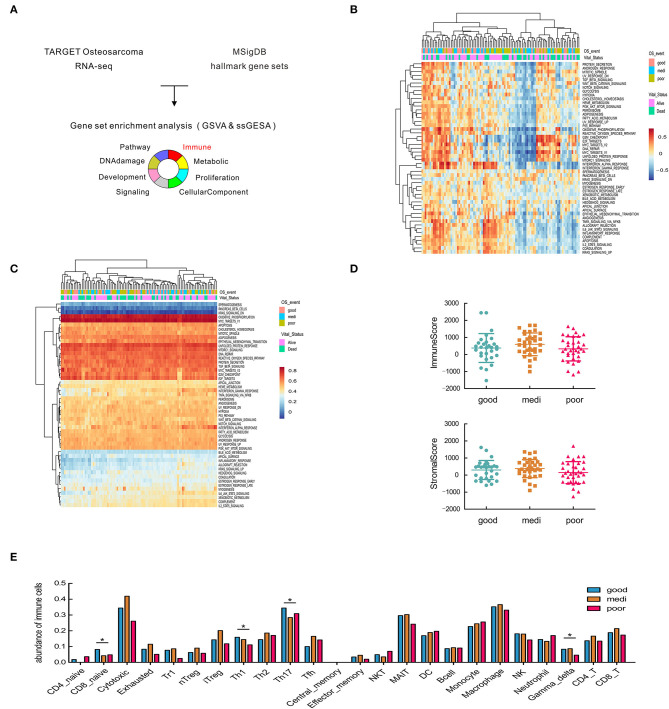
Significant heterogeneity in immune-related gene sets among patients with osteosarcoma and its correlation with disease prognosis. (A) Schematic representation of gene set enrichment analysis. (B,C) Heatmap of GSVA and ssGSEA analysis in the hallmark gene set. (D) Estimate of overall immune and stromal scores based on gene expression data. (E) Comparisons of 24 tumor-infiltrating immune cells among groups. Asterisks (*) indicate results that are statistically significance at p-value. *p < 0.05; **p < 0.01.